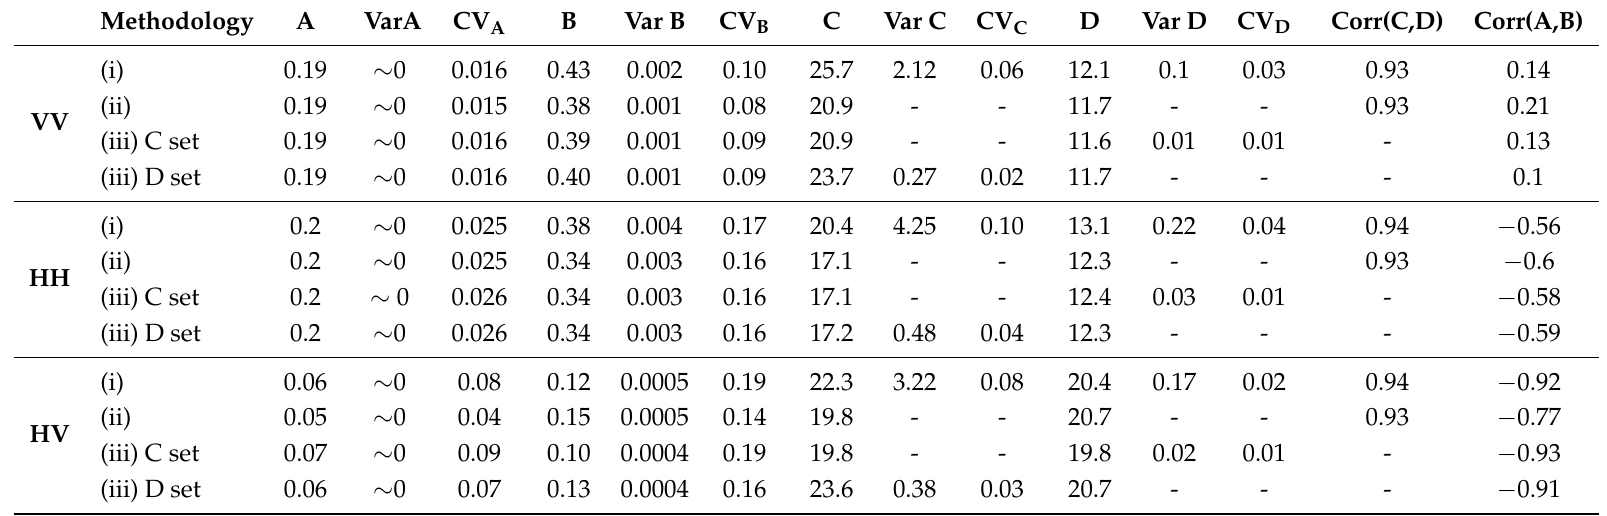
Table 2. Values of the parameters obtained for each methodology and each polarization, along with their associated variances, coefficients of variation and correlation as derived by means of the Hessian